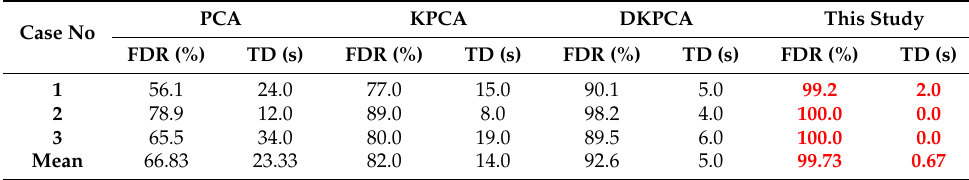
Figure 10. Acid gas adsorption process fault diagnosis result (( a )—case 1 fault detection result, ( b )—case 2 fault detection result, ( c )—case 3 fault detection result, ( d )—fault identification result). Table 6. Comparison with PCA, KPCA, DKPCA in FDR and